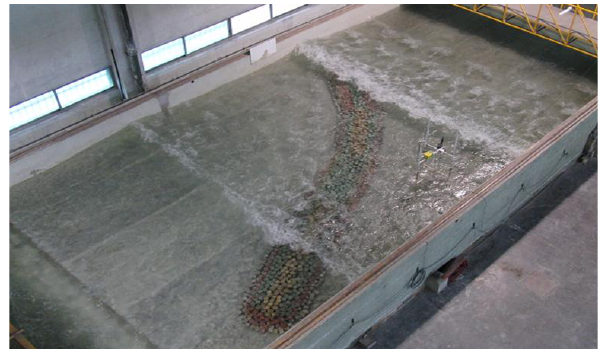
Fig. 5. Generated waves. Two big waves and small waves between them.